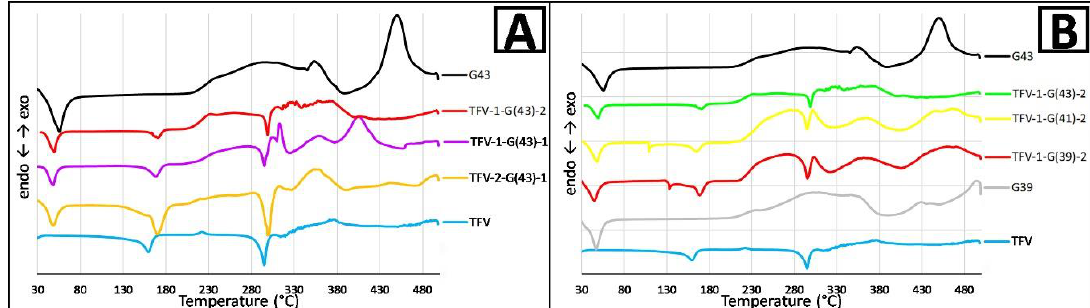
Figure 3. Differential scanning calorimetry (DSC) curves of TFV, G43 and their combinations ( A ); and TFV, G43, G39 and their combinations in a ratio of 1:2 of TFV/Gelucire® ( B ).